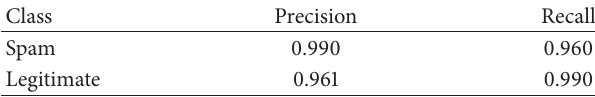
Table 3: Precision and recall of 200 user datasets.